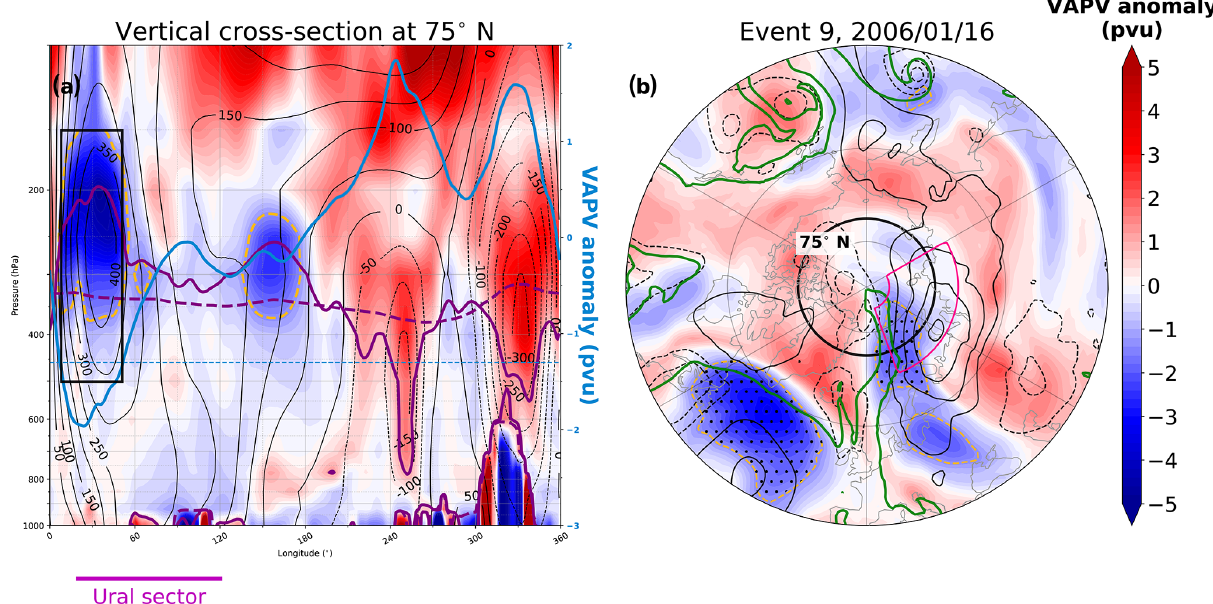
Figure 1. An illustrative example of the blocking identification algorithm for 12:00UTC on 16 January 2006, 1d prior to event 9. (a) Vertical cross section along 75 ◦ N showing PV anomaly (shading, − 1.3pvu isoline highlighted by orange, dashed line), tropopause at 2pvu (purple solid), climatological tropopause (purple dashed) and geopotential height anomalies (black contours every 50gpm, geopotential height meters). Also shown is the VAPV anomaly and the threshold of − 1.3pvu (light-blue solid and dashed contour, respectively; scale on the right). The Ural sector is indicated by a magenta horizontal line below the figure, and the black box highlights the identified Ural block. Note the logarithmic scale in the vertical. (b) VAPV anomaly (shading) overlaid with SLP anomalies (hPa, black contours every 10hPa, negative values dashed, zero contour not shown), total column water (5kgm − 2 isoline, green solid) and VAPV anomaly ( − 1.3pvu, orange dashed). Dotted areas show the identified blocking regions, and the black line and the magenta box indicate the location of the cross section in panel (a) and the Ural sector,